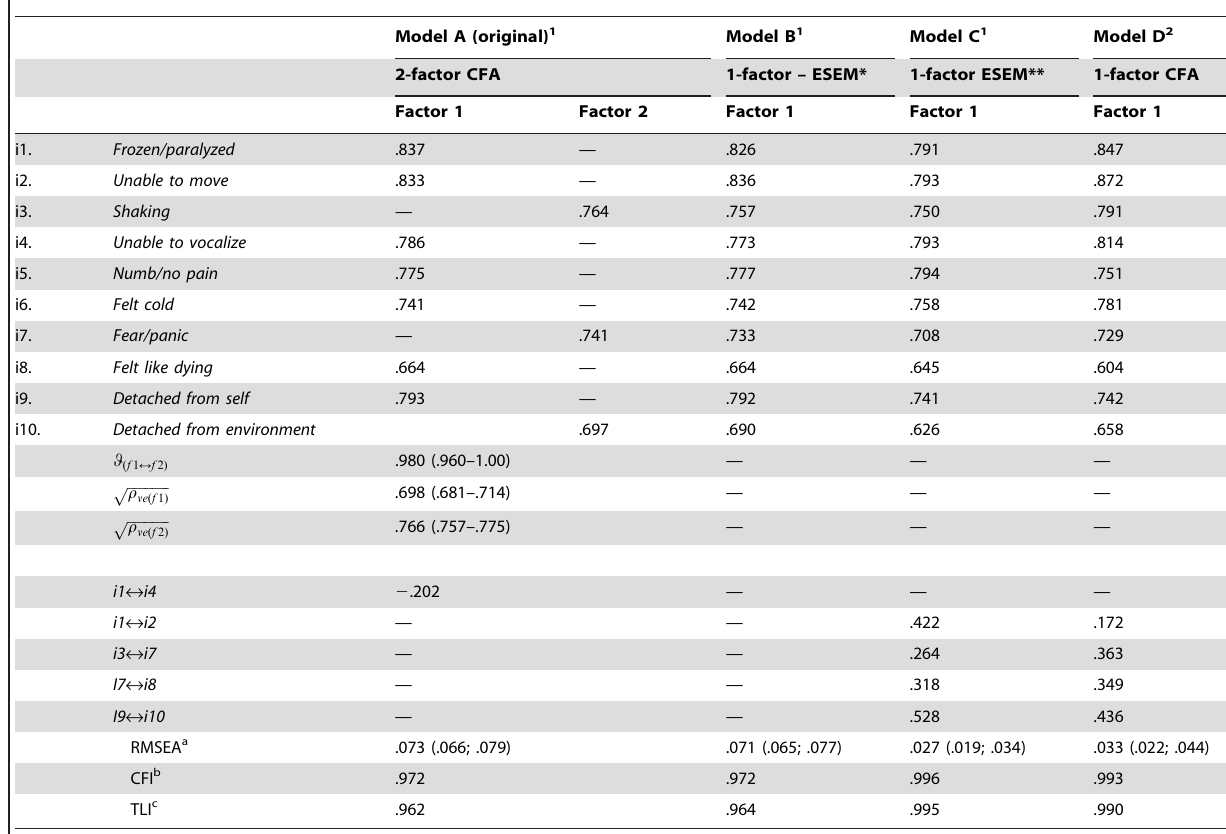
Table 3. Sequence of models concerning the Tonic Immobility Scale